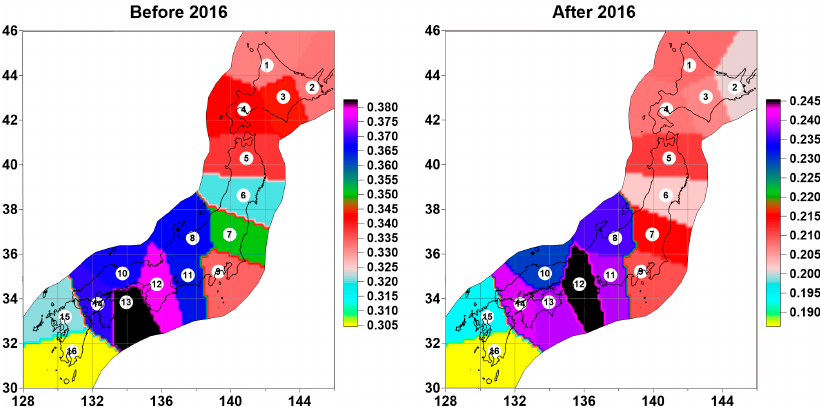
( j ) τ from reference